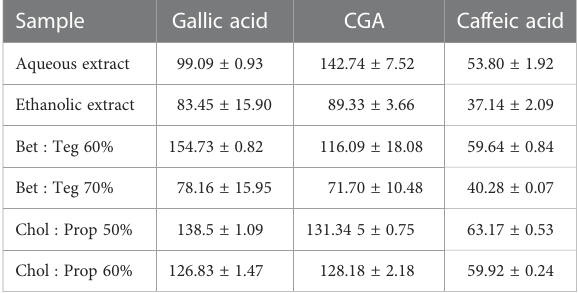
TABLE 1 Gallic acid, 3-O-caffeoylquinic acid (CGA), and caffeic acid content (average values of three replicas) expressed in mg/kg of SCG. Sample Aqueous extract Ethanolic extract